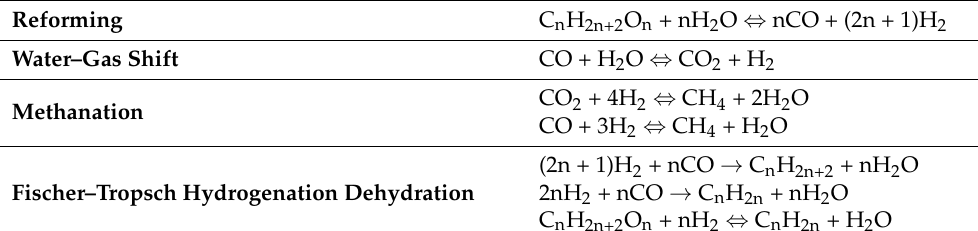
Table 1. Main reactions involved in the APR process [23,27,28].